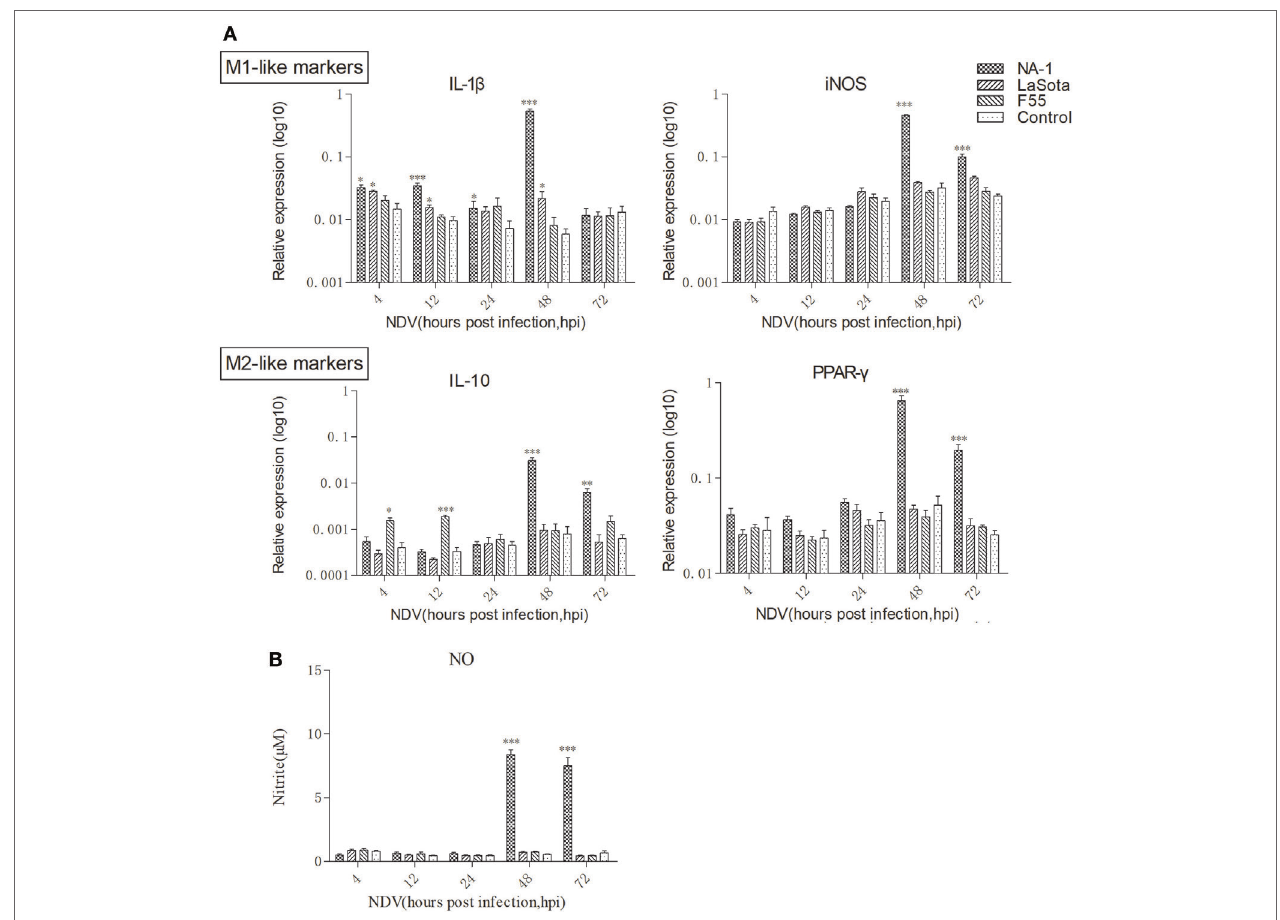
FigUre 3 | Dynamic polarized activation of chicken macrophages induced by virulent and lentogenic viruses. Expression levels of M1-like (IL-1 β and iNOS) and M2 (IL-10 and PPAR- γ ) genes in HD cells infected with three different virulence and genotypes Newcastle disease virus (NDV) strains at a multiplicity of infection of 2 for 4–72 h was analyzed by qPCR method (a) . Nitrite, a stable metabolite of nitric oxide, produced by activated M1-like macrophages was measured by the Griess assay (b) . All qPCR data were normalized to the geometric mean of cellular endogenous genes β -actin and hydroxymethylbilane synthase and calculated using the 2 −Δ Ct method. All values are shown as mean ± SEM ( n = 4–6) and differences were considered significant if * P < 0.05, ** P < 0.01, and *** P < 0.001 as compared to the respective control (uninfected) cells. All data are representative of at least three independent